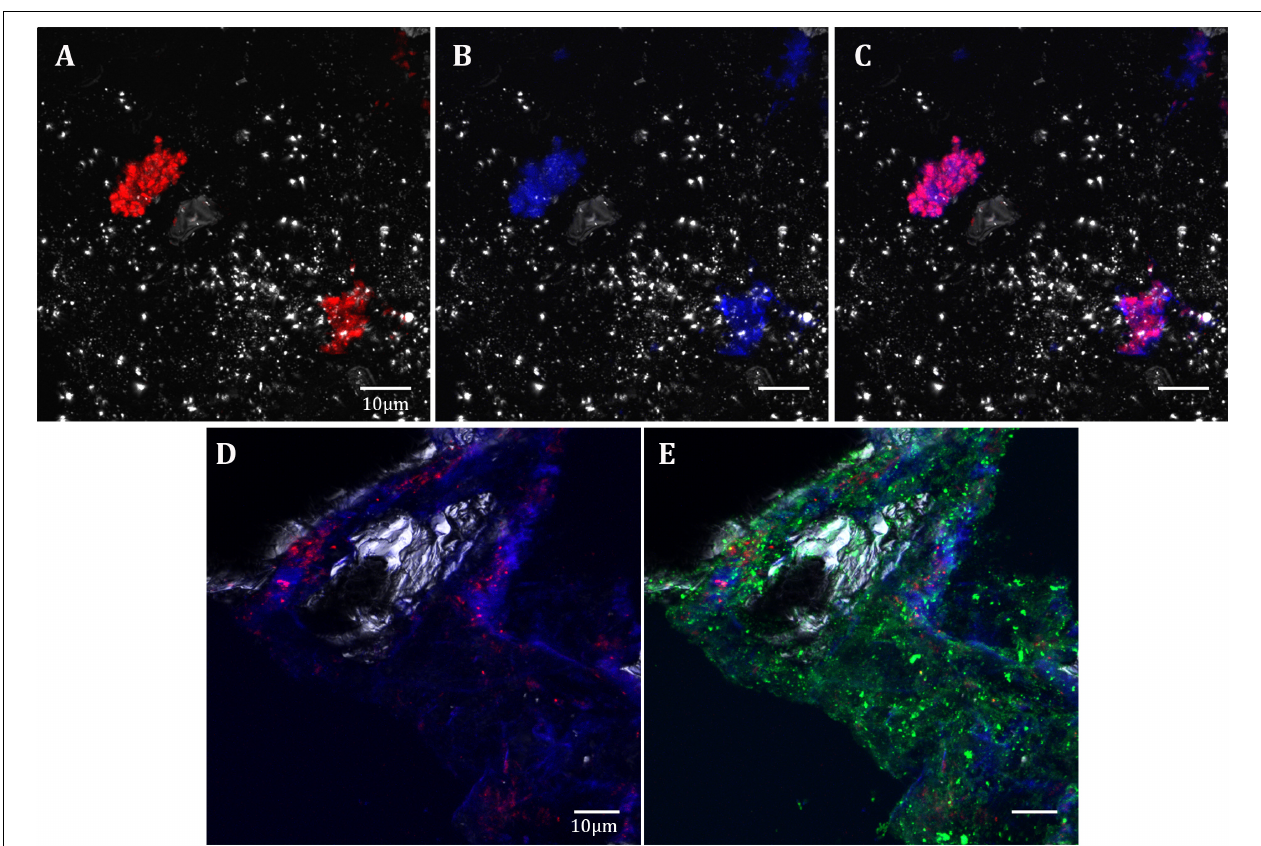
FIGURE 8 | Acidovorax -Fe 3 + -EPS co-localization in the IPB subsurface. DOPE-FISH with Acidovorax probe (red) at 414.8 mbs (A–C) and at 139.4 mbs (D,E) ; In blue, Fe 3 + signal. In green, ConA lectin signal. In gray, reflection. Scale bars 10 µ m.